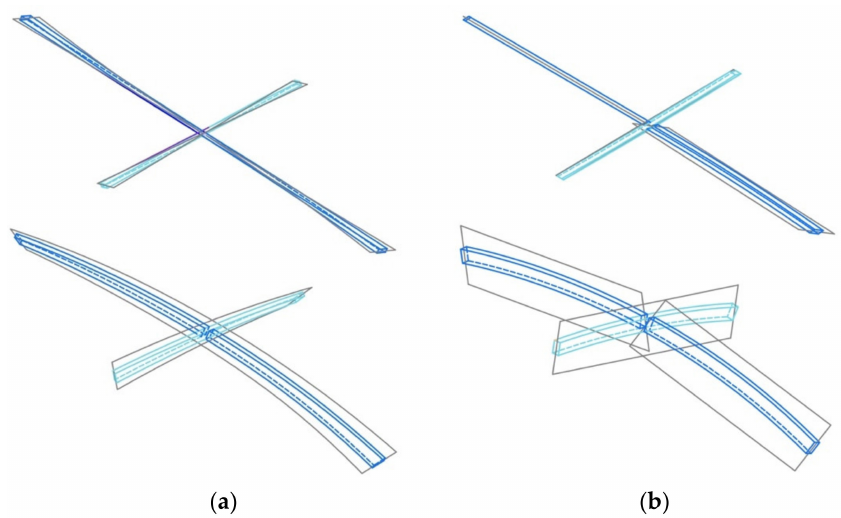
Figure 10. The axonometric view of the intersection of the lamellae at the node ( a ) showing the lamel- lae axes following the helix curve obtained by the numerical method, and ( b ) showing vertical axial planes of the lamellae in order to present the rotation at the node obtained by the graphical